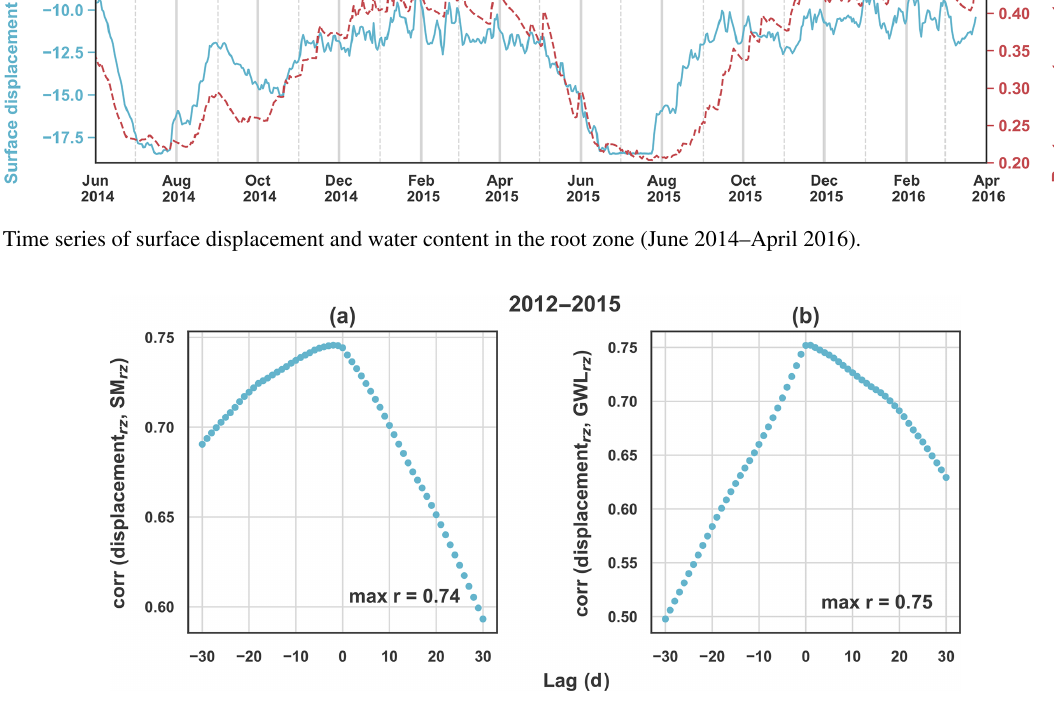
Figure 6. Correlation coefficient ( r ) between: (a) displacement and SM, (b) displacement and GWL in the root zone with time lags as much as 30d during 4 years at Veenderij